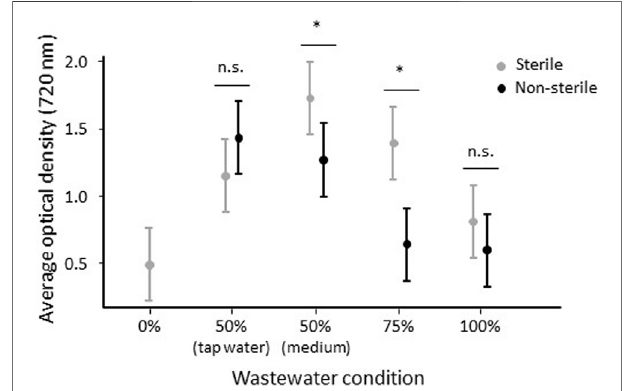
FIGURE 5 | Average optical density (720 nm) of C. sorokiniana cultures in relation to wastewater dilution and medium sterilization. Whiskers delineate the upper and lower 95% con fi dence limit. Non-/signi fi cant differences are based on Tukey-corrected post-hoc tests and are indicated with n.s or an asterisk (*),